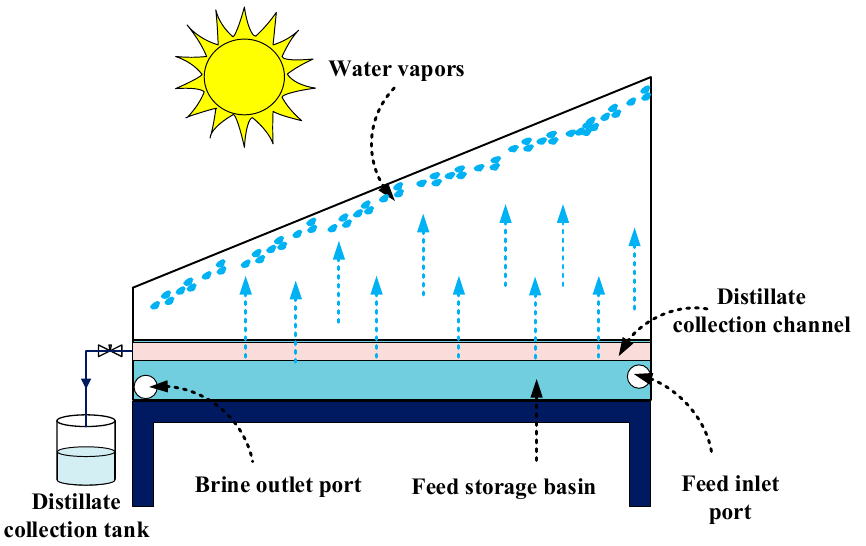
Figure 2. Schematic diagram of the single-slope solar still.